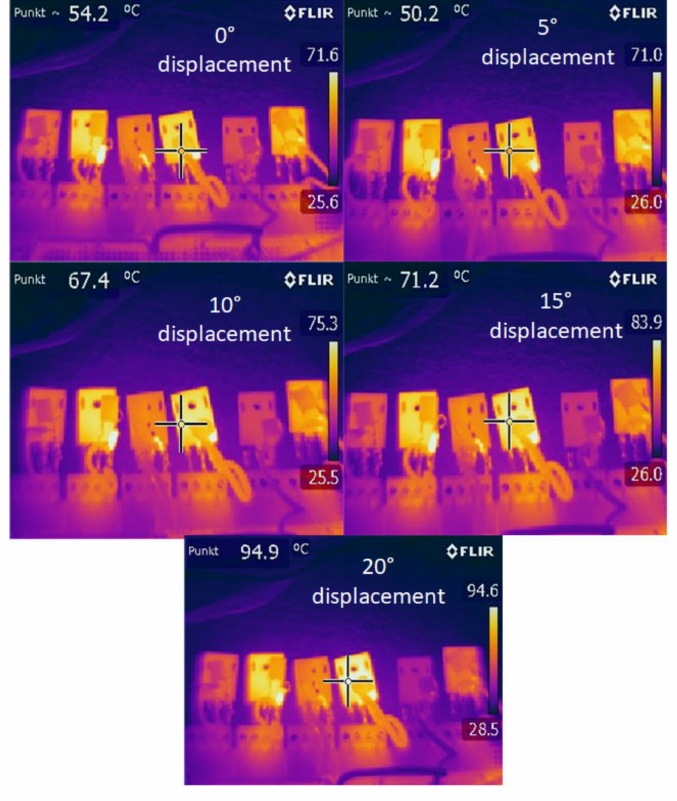
Figure 10. Image of the temperature distribution of the inverter transistors for different Hall B